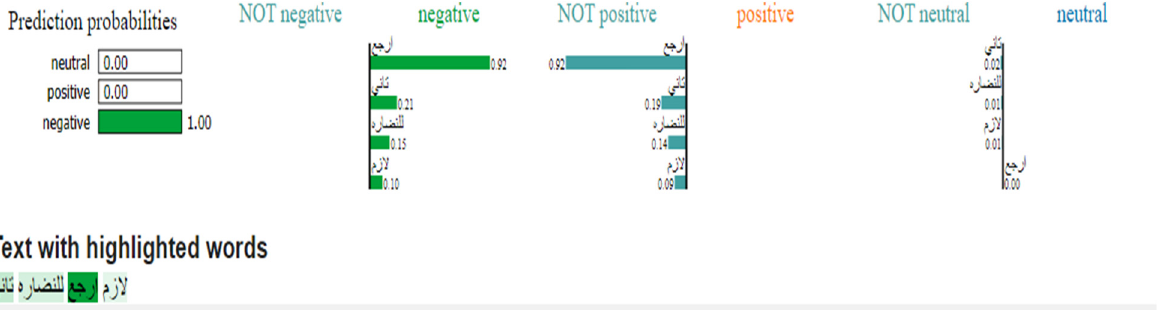
Figure 6. LIME results for LASIK surgery negative sentiment.